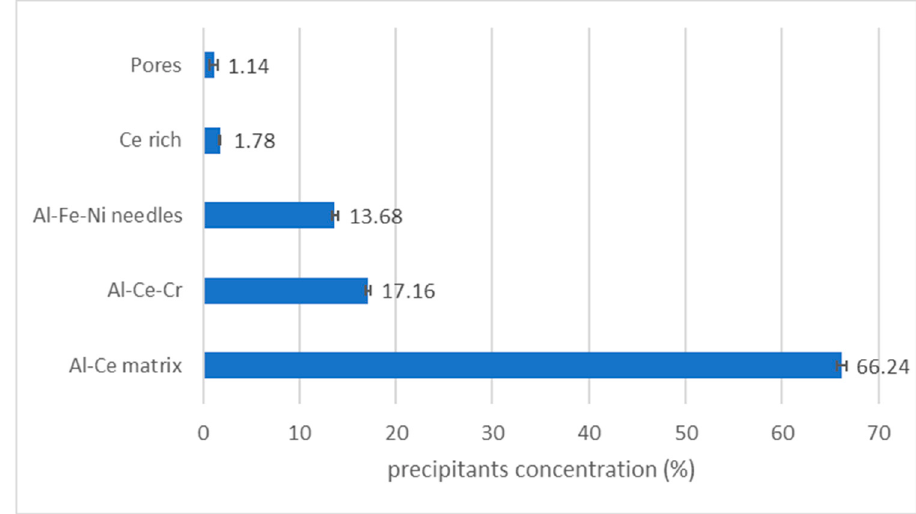
Figure A3. PIT Al-8Ce wt % precipitants concentration.